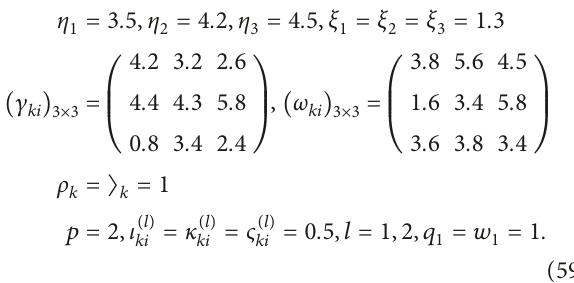
Figure 7: (a) Trajectories of control parameters η ( t ) , ξ ( t ) , and ξ ( t ) with the adaptive controller rameters ξ 1 2 3